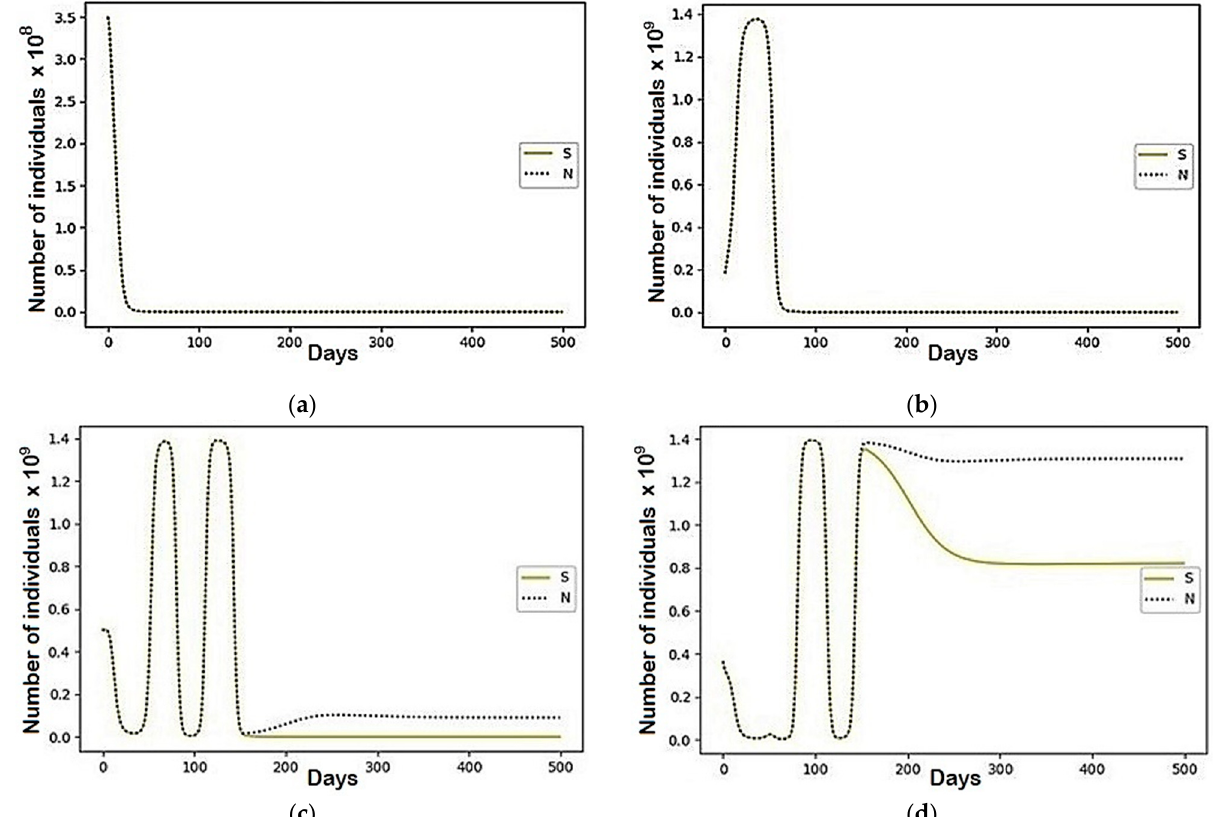
Figure A4. The modeling results describing the total population size (N) and the population belonging to the susceptible (S) group using the parameters represented in Table 2: ( a ) Region 1; ( b ) Region 3; ( c ) Region 2; ( d ) Region 4.